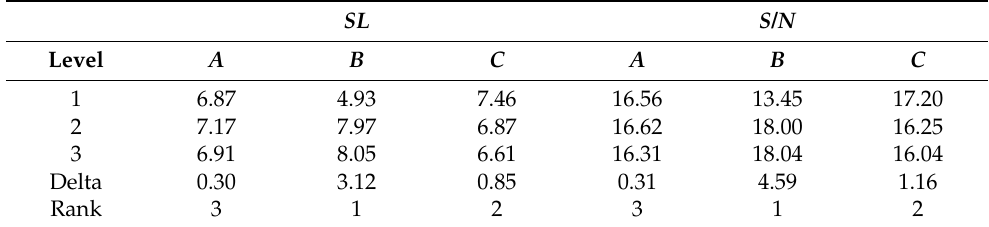
Table 1. The average SL and S / N ratio values.